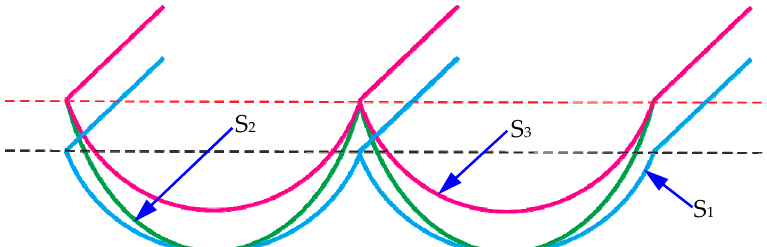
Figure 4. Schematic illustration for the influence of material spring back and plastic side flow on the surface topography in one tool feed (S 1 : only considering the duplication effect of tool edge profile; S 2 : considering the influence of duplication effect and plastic side flow; S 3 : considering the influence of duplication effect, material spring back and plastic side flow). Reproduced with permission from [47].